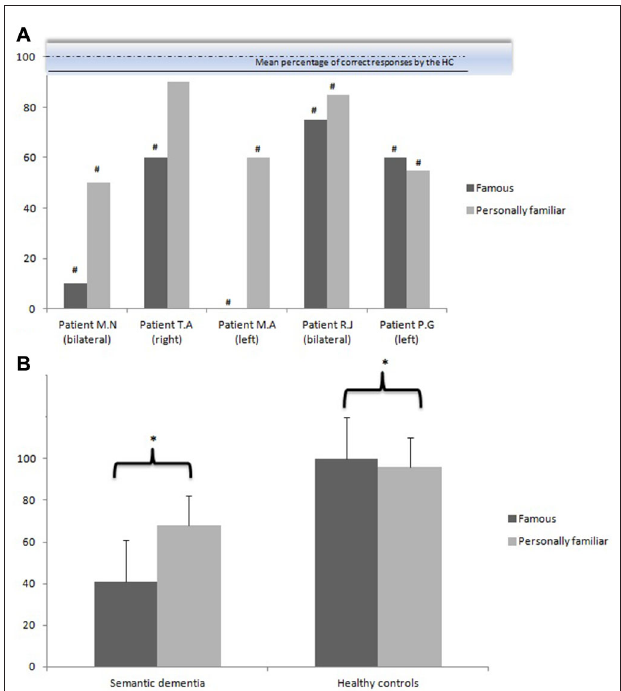
FIGURE 1 | Mean percentage of correct responses (and standard errors) on the familiarity judgment task in both experimental conditions (personally familiar names vs.famous names) by the semantic dementia group (displayed by each patient in (A), at the group level in (B) and the healthy controls (HC) (B) Bilateral, right, left: laterality of the temporal atrophy . # Significant ( p < 0.05) in comparison to the healthy controls (inter-group analyses). ∗ Significant ( p < 0.05) in comparison to the other experimental condition (intra-group analyses).